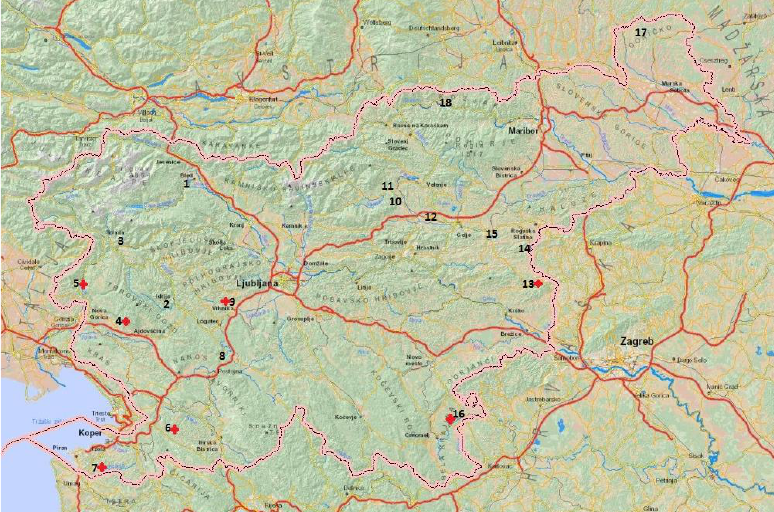
Figure 1. Map of Slovenia with marked localities with high intraspecies variability of C. purpurascens (1 — Bled, 2 — Idrija, 3 — Tolmin, 4 — Lijak, 5 — Plave, 6 — Slivje, 7 — Dragonja, 8 — Planina,